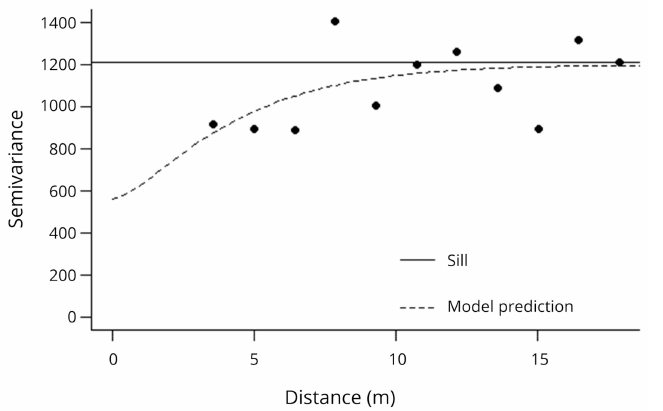
Figure 6. Variogram of total soil C stock (ESM 4800) for all pairs of sample points ≤ 20 m apart displaying the spatial dependence of the samples and displaying point pairs for sample locations 20 m apart or less. The best fit variogram model (Mat é rn model) with a smoothness parameter of 1 (the dotted line) estimates the nugget at 580, and the sill (solid line) at 1180, indicating a spatial dependence (nugget/sill) of